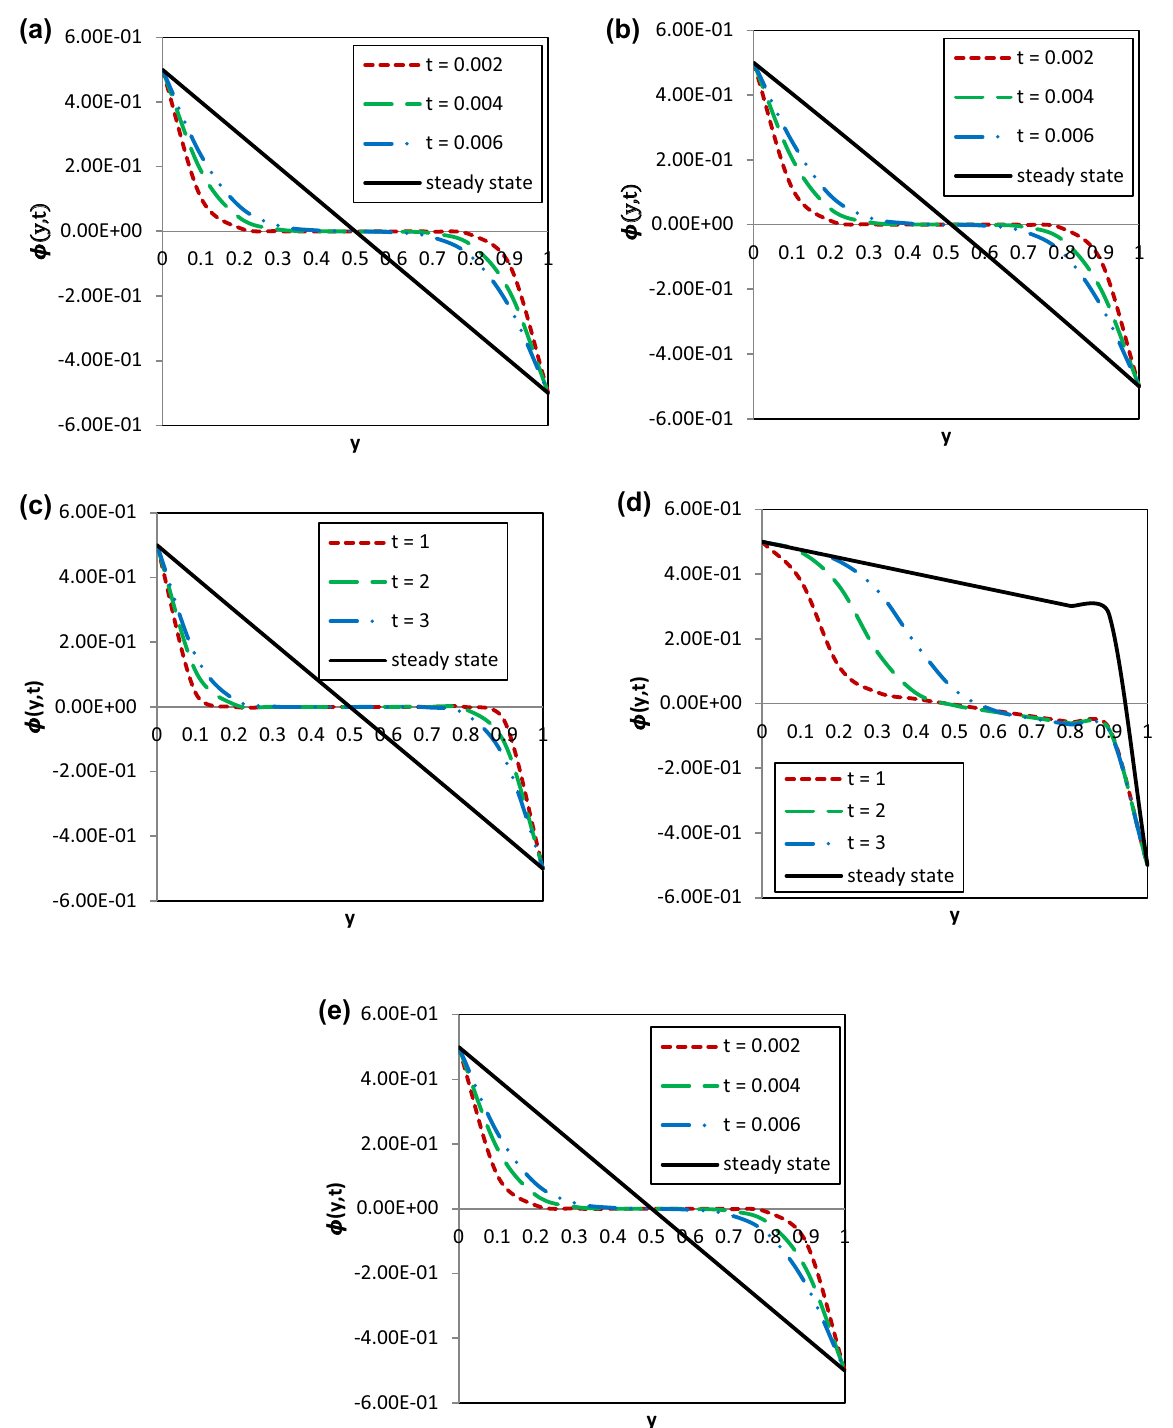
Fig. 3 a Concentration profile for ( k = 0.0, Pr = 0.71, Sc = 0.6, = 2.0, N = 8.0, Bi = 10, Bi = 10 ) . b Concentration profile for N 1 2 c t ( k = 2.0, Pr = 0.71, Sc = 0.6, N t = 8.0, Bi 1 = 10, Bi 2 = 10 ) 𝜆 = 100, 𝛼 = 10, = 2.0, . c Concentration profile for ( k = 0.0, Pr = 0.71, Sc = 600, b = 10, N c 𝜆 = 100, 𝛼 = 10, b = 10, N c = 2.0, N t = 8.0, Bi 1 = 10, Bi 2 = 10